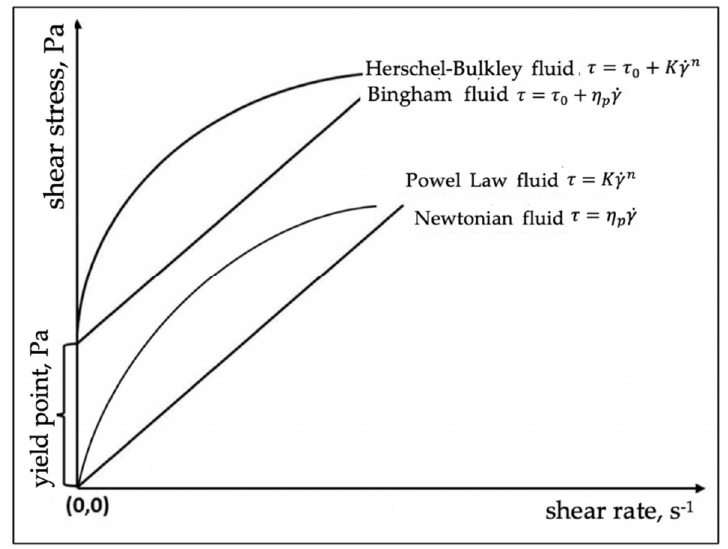
Figure 1. Flow curves of fluids obeying different flow models.